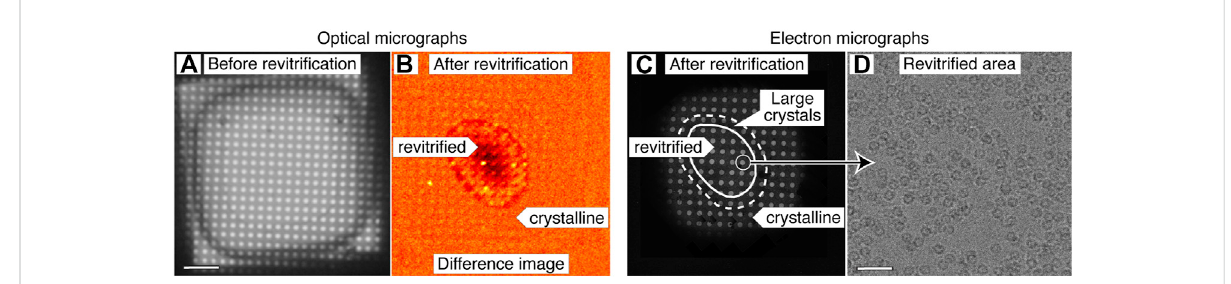
FIGURE 2 Correlative light-electron microscopy of a cryo sample that was revitri fi ed in the optical microscope. (A) Optical micrograph of a typical grid square of an apoferritin cryo sample. (B) Difference image of the sample after melting and revitri fi cation with a 40 µs, obtained by subtracting the image before revitri fi cation from one recorded after. The revitri fi ed area in the center of the grid square features a thin, dark outline that arises from theformationofcrystalsinthesurrounding area. Adarkpatchinthecenterindicatesthinningofthesample duetoevaporation. (C) An electron micrograph of the same area con fi rms the interpretation of the image contrast in (B) . The outline of the revitri fi ed area is marked with a solid line. A dashedlineindicatestheregioninwhichtheformationoflargecrystalsisobserved. (D) Micrographrecordedintheareacircledin (C) ,showingintact apoferritin particles. Scale bars, 10 µm in (A) and 40 nm in (D)